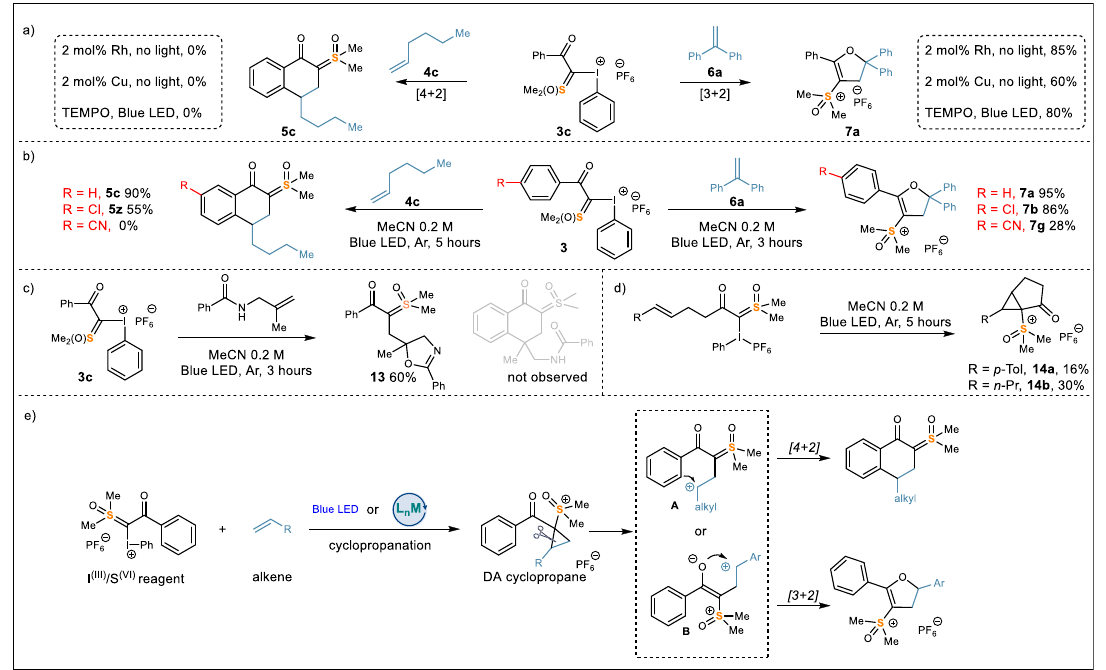
Fig. 6 | Mechanistic study. a Control experiment with metal catalysts and radical trapping experiment with TEMPO (2,2,6,6-tetramethylpiperidinooxy); b Substitutions effect; c Cation trap experiment; d Intramolecular cyclopropanation; e Proposed reaction mechanism.